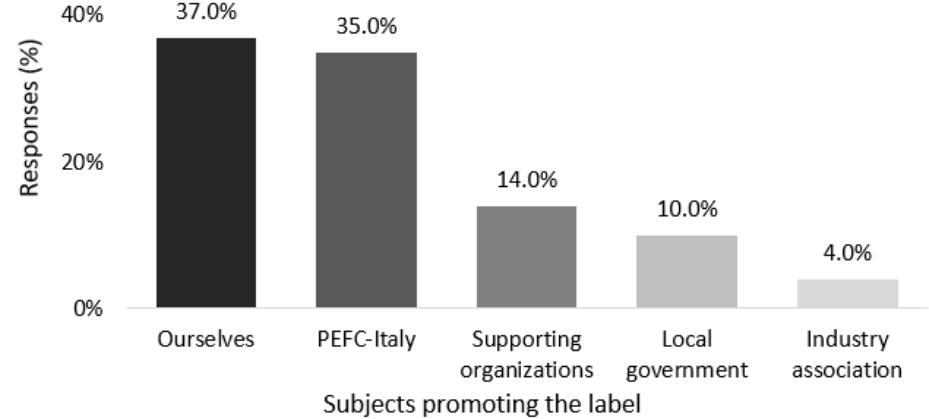
Figure 10. Subjects promoting the label as declared by respondents.